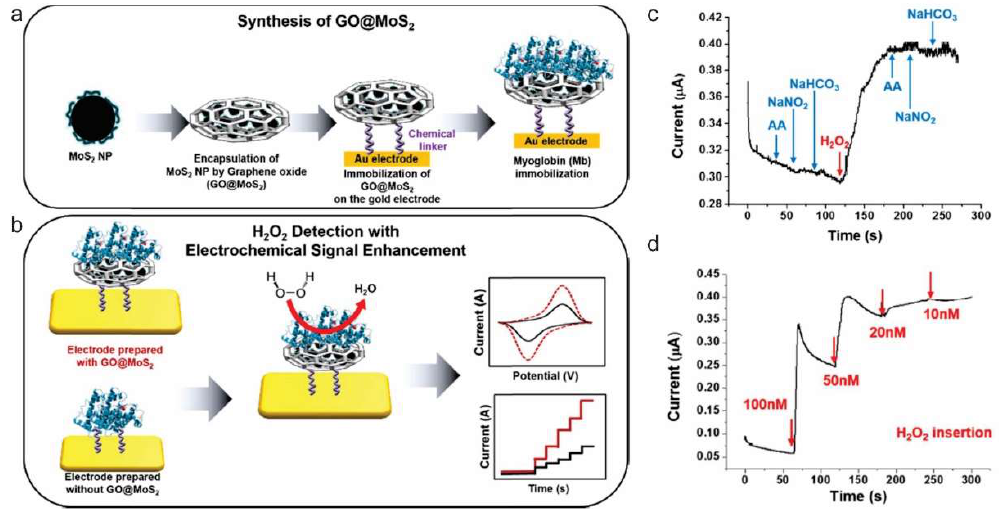
Figure 2. ( a ) Schematic of graphene oxide encapsulated molybdenum disulfide (MoS2) nanoparticle preparation for the fabrication of electrochemical biosensors composed of myoglobin (Mb) and ( b ) its application to H 2 O 2 detection with improved electrochemical performance. ( c – d ) Amperometric response curves obtained from Mb/GO@MoS 2 upon successive ( c ) addition of 100 nM L-ascorbic acid (AA), 100 nM sodium nitrite (NaNO 2 ), 100 nM sodium bicarbonate (NaHCO 3 ), and 100 nM H 2 O 2 solutions; and by ( d ) addition of 100, 50, 20, and 10 nM H 2 O 2 solutions. Reproduced with permission from [56], Copyright Elsevier, 2017. Table 2. Comparison of different graphene-based electrode for small molecule detection. Electrode Materials Target Linear